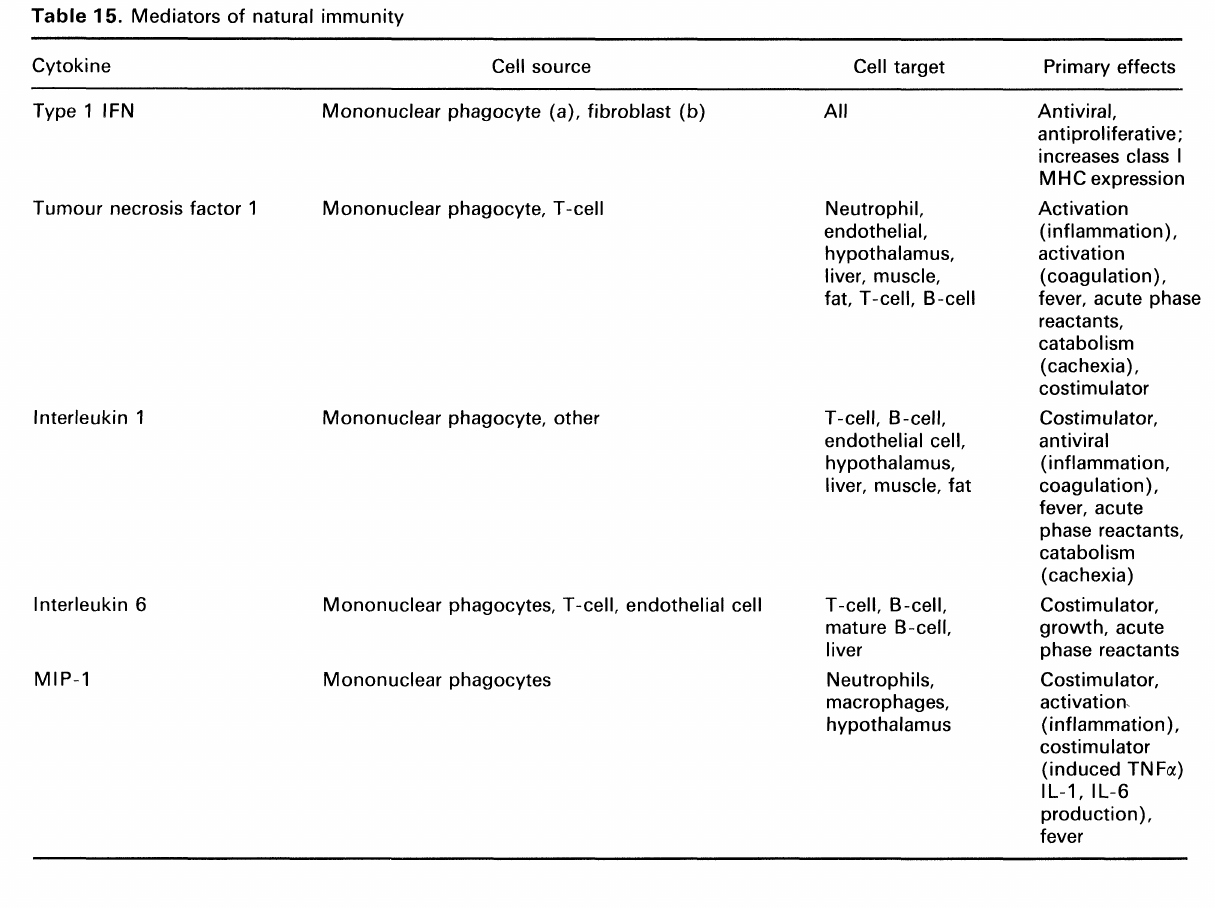
Table 15. Mediators of natural immunity